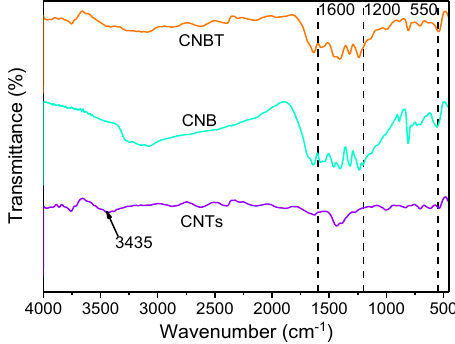
Figure 3. FTIR spectra of CNTs, CNB and CNBT.